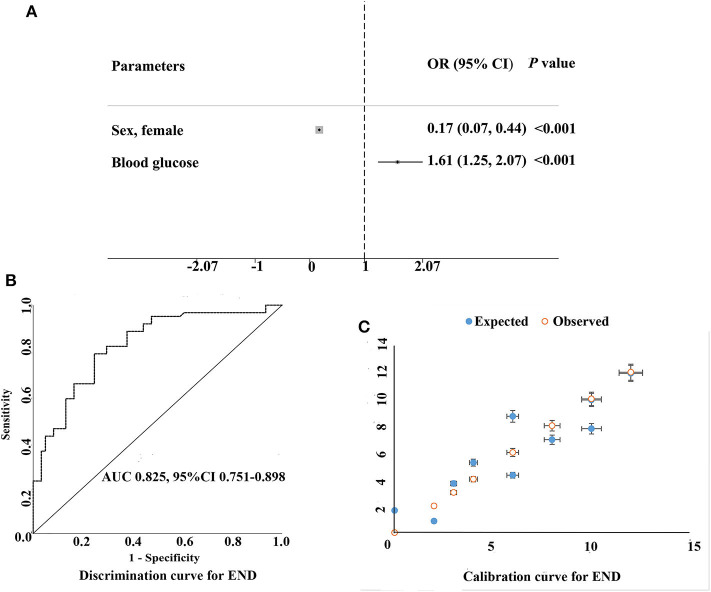
Multivariable logistic model on identifying the predictors of early neurological deterioration following PSM matching. (A) Multivariable-adjusted odds ratios (diamonds) and 95% confidence intervals (CI; bars) for risk factors of early neurological deterioration were shown. (B,C) show the discrimination and calibration of the prediction model respectively, for example, the AUC of the area under the ROC curve is 0.825 > 0.75 and the 95% CI is 0.751−0.898, suggesting that the prediction model has good discrimination ability. (C) shows the consistency between the predicted risk of the model and the actual observed occurrence risk.